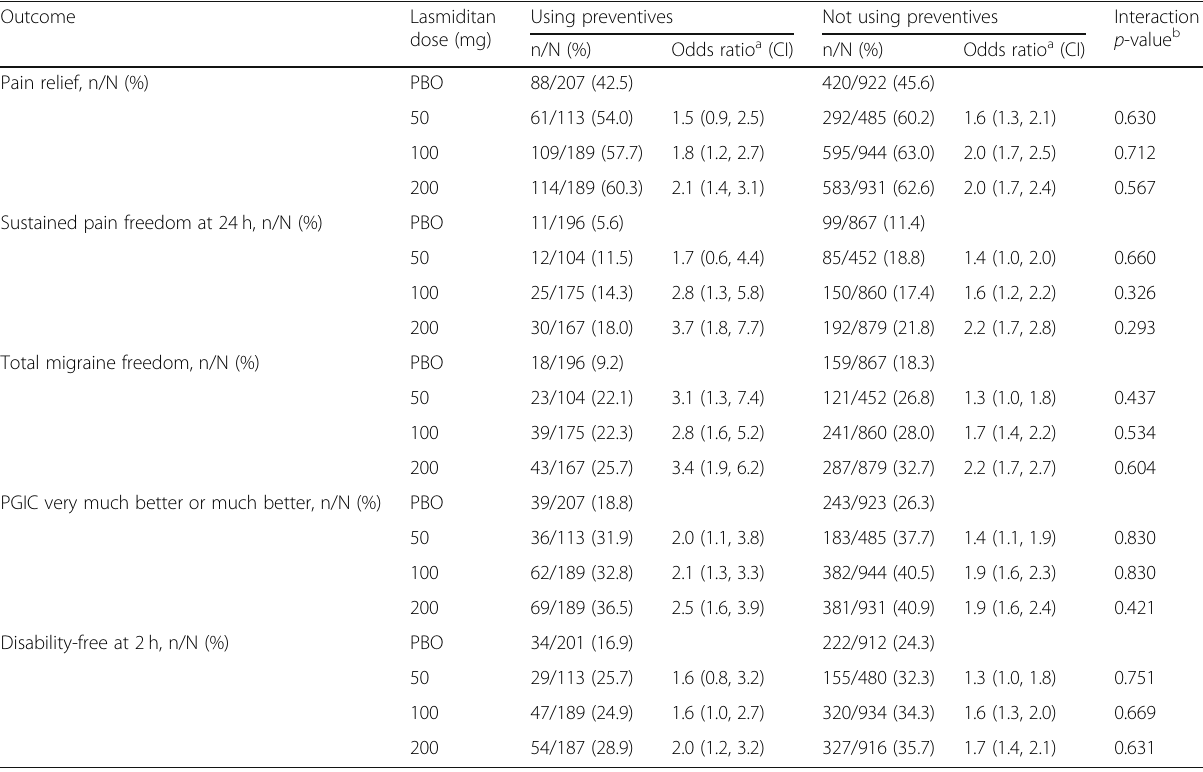
Table 4 Secondary efficacy outcomes were not significantly different between patients using and not using migraine preventive medications, for all doses of lasmiditan Outcome